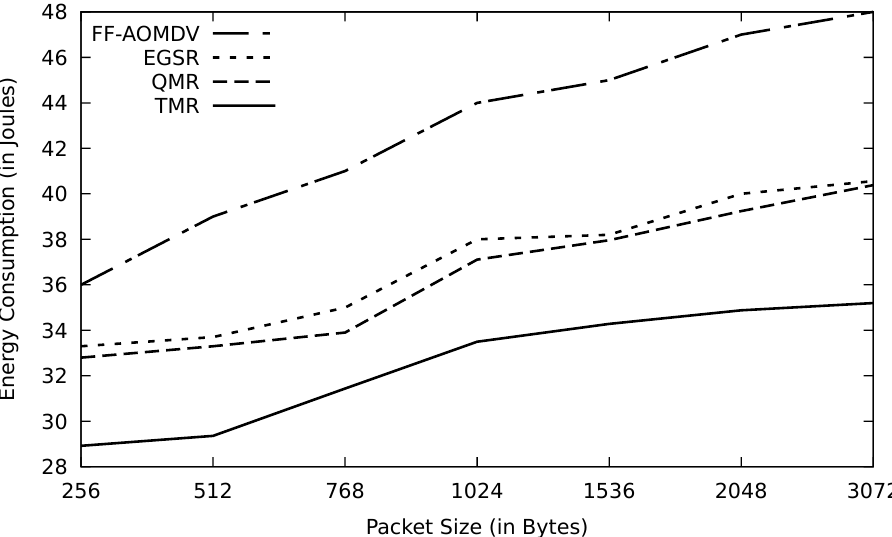
Figure 10. Comparison of FF-AOMDV, EGSR, QMR, and proposed protocol TMR for energy con- sumption with different packet